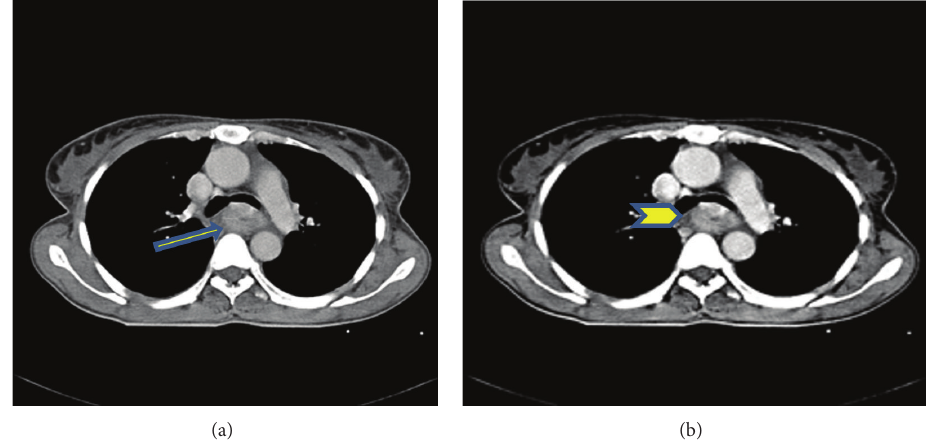
Figure 2: Computed tomography of esophageal mass (arrows) before neoadjuvant therapy.